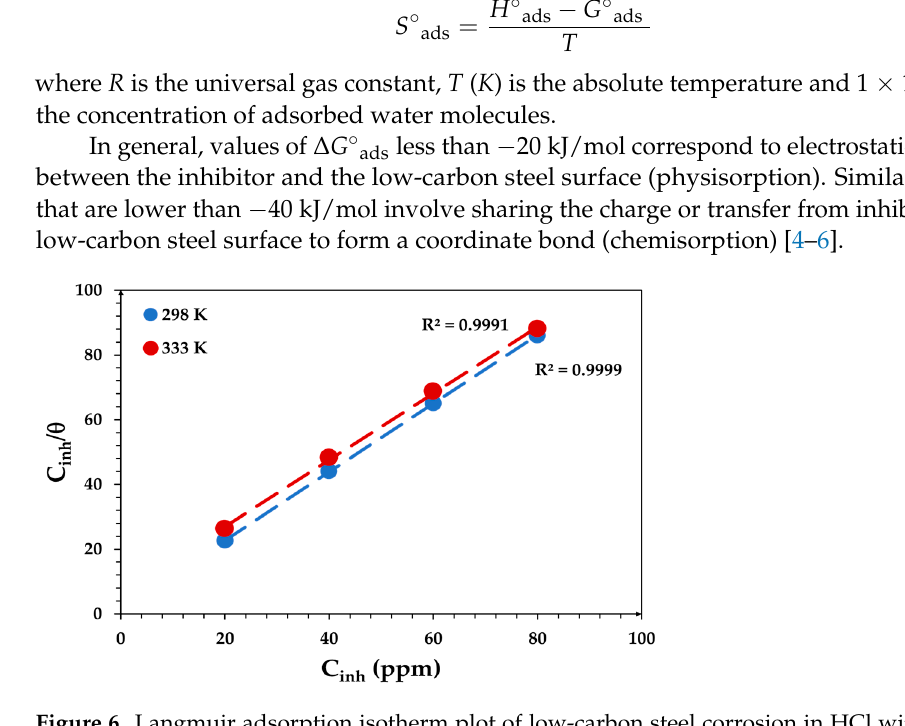
Figure 6. Langmuir adsorption isotherm plot of low-carbon steel corrosion in HCl with different concentrations of CoO/Co 3 O 4 NPs at 298 and 333 K.